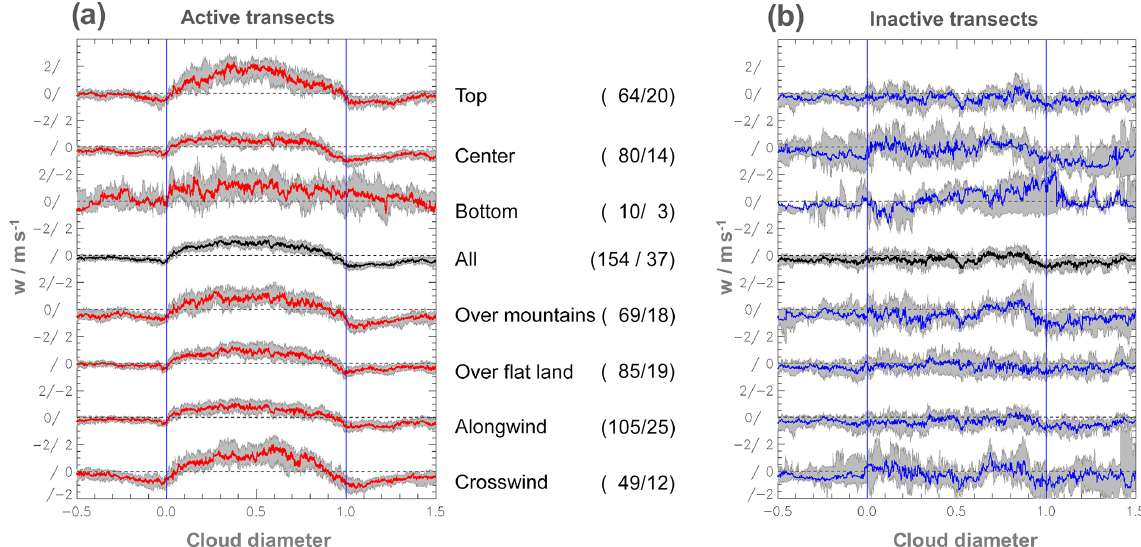
Figure 8. (a) Median of the vertical wind for different transect heights, terrain direction for the active cloud transects. The comparison is based on the 191 cloud transects shown in Fig. 7, with the same scaling of the x axis. The red lines show active clouds. The detailed selection is explained between the two panels of the respective line including the number of involved cases (i.e. active/inactive cases). For better readability the lines are vertically shifted and the dashed horizontal grey lines show the different 0 lines. Two adjacent 0 lines are separated by 4ms − 1 . In order to show the statistical significance of the transect samples, a statistical resampling (bootstrapping method) with 1000 repetitions is performed. The resulting spread of the 95% confidence interval for each transect category is shown by the grey shaded area. (b) Same for the inactive transects (blue lines). Table 6. Vertical wind speeds (ms − 1 ) of 191 selected cloud transects. The length of the cloud interior is variable and the shells are limited to 20% of the cloud diameter. The table shows the mean vertical velocities, the median and the 25th and 75th percentiles. Mean 25th percentile median 75th percentile Cloud + 0 . 5 − 0 . 7 + 0 . 4 + 1 . 7 Upwind shell − 0 . 4 − 0 . 9 − 0 . 3 + 0 . 2 Downwind shell − 0 . 7 − 1 . 4 − 0 . 6 + 0 . 1 Crosswind shell − 0 . 8 − 1 . 6 − 0 . 7 + 0 .